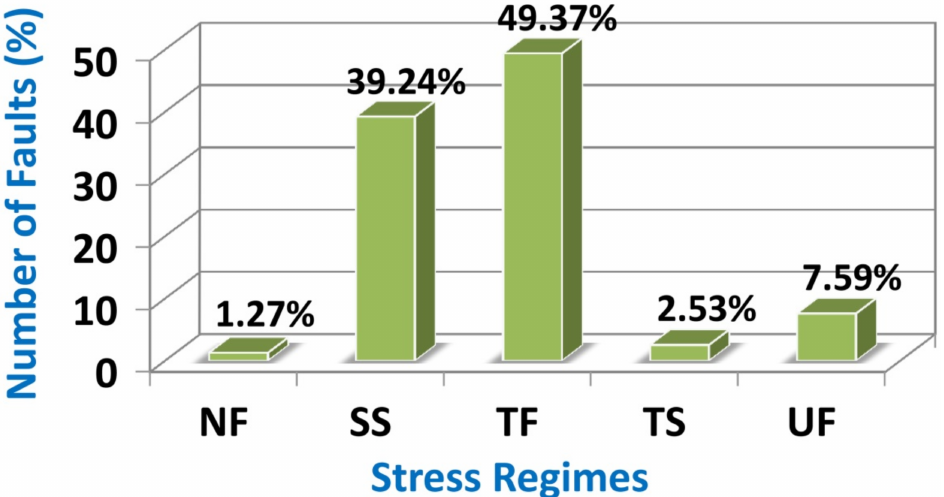
Figure 3. The statistical evaluation of tectonic stress regimes estimated from the focal mechanisms for the study area (NF, SS, TF, TS, and UF symbols are normal, strike-slip, thrust, thrust with a strike-slip, and unknown faulting,